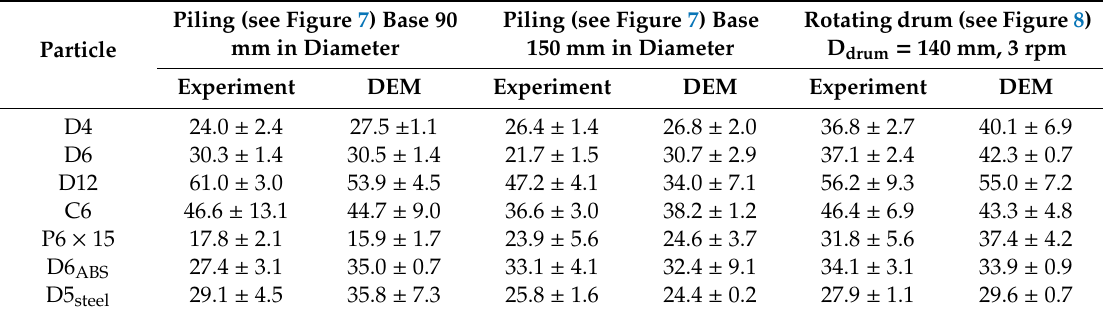
Figure 8. Calibration procedures of virtual particulate materials according to static angle of repose. Table 14. Experimental and calibrated AoR values evaluated via graphical